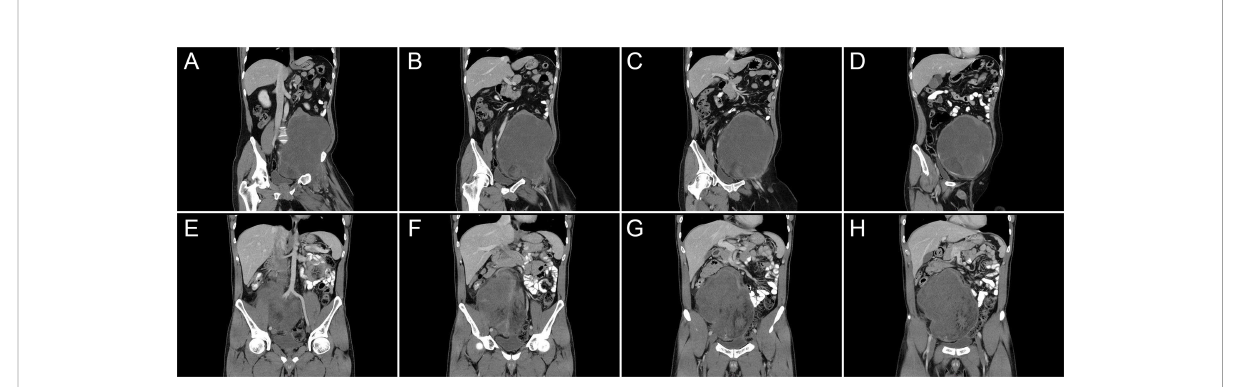
FIGURE 1 Representative imaging of retroperitoneal sarcoma in the left (A – D) and right (E – H) lower quadrants of the abdomen, which extend laterally and obscure the iliac